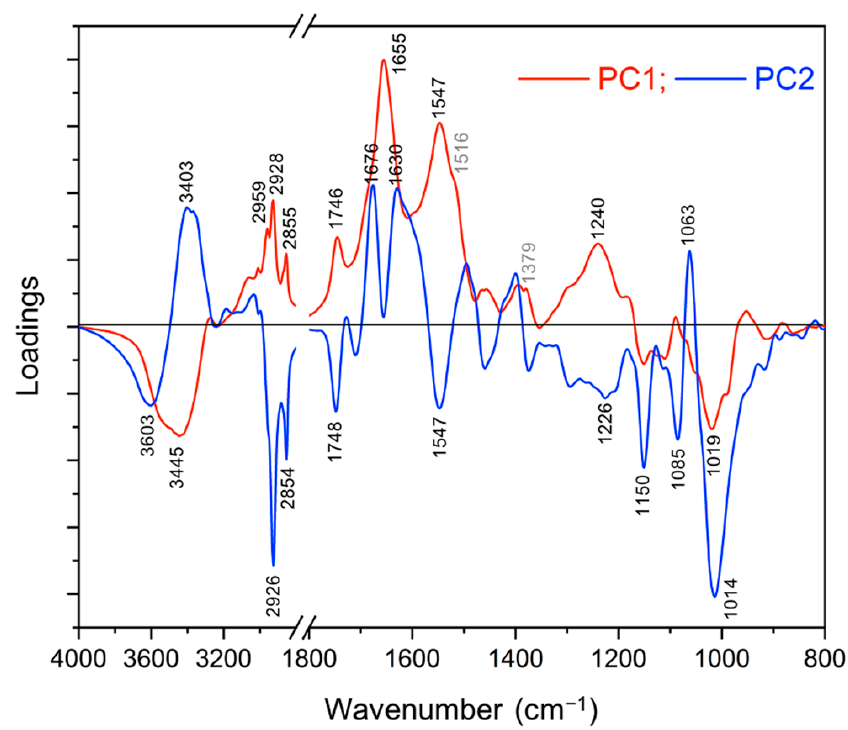
Figure 5. Loadings plot (PC1 & PC2) of the root samples based on the FTIR spectra. Each point in the plot represents the projection of a spectrum in the PC1–PC2 space.